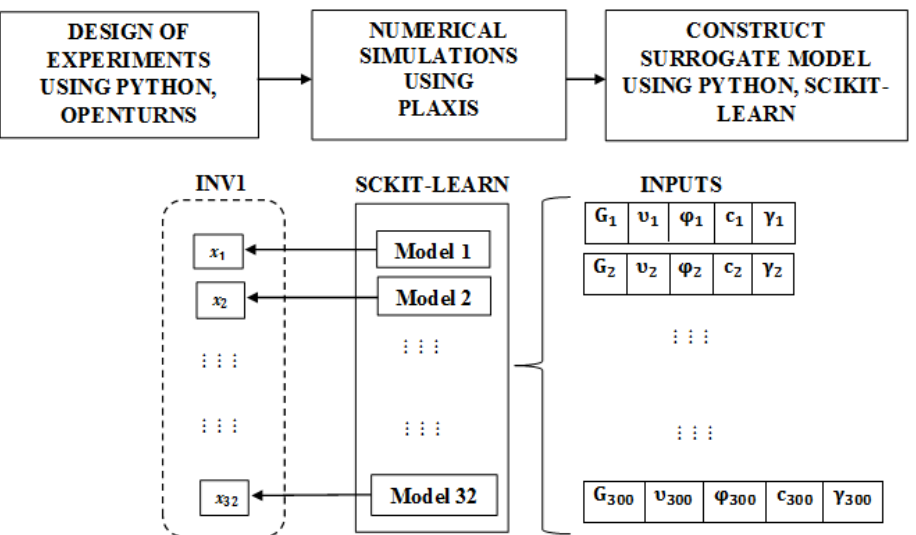
Figure 8. Steps involved in generating a surrogate model of a rockfill dam. Thirty two evenly distributed locations along the inclinometer were considered for the analysis. A set of five parameters was used to generate the 300 input points. These inputs were used to create the regression models for the 32 locations using the Sckit-learn package and the actual displacement values at these locations.